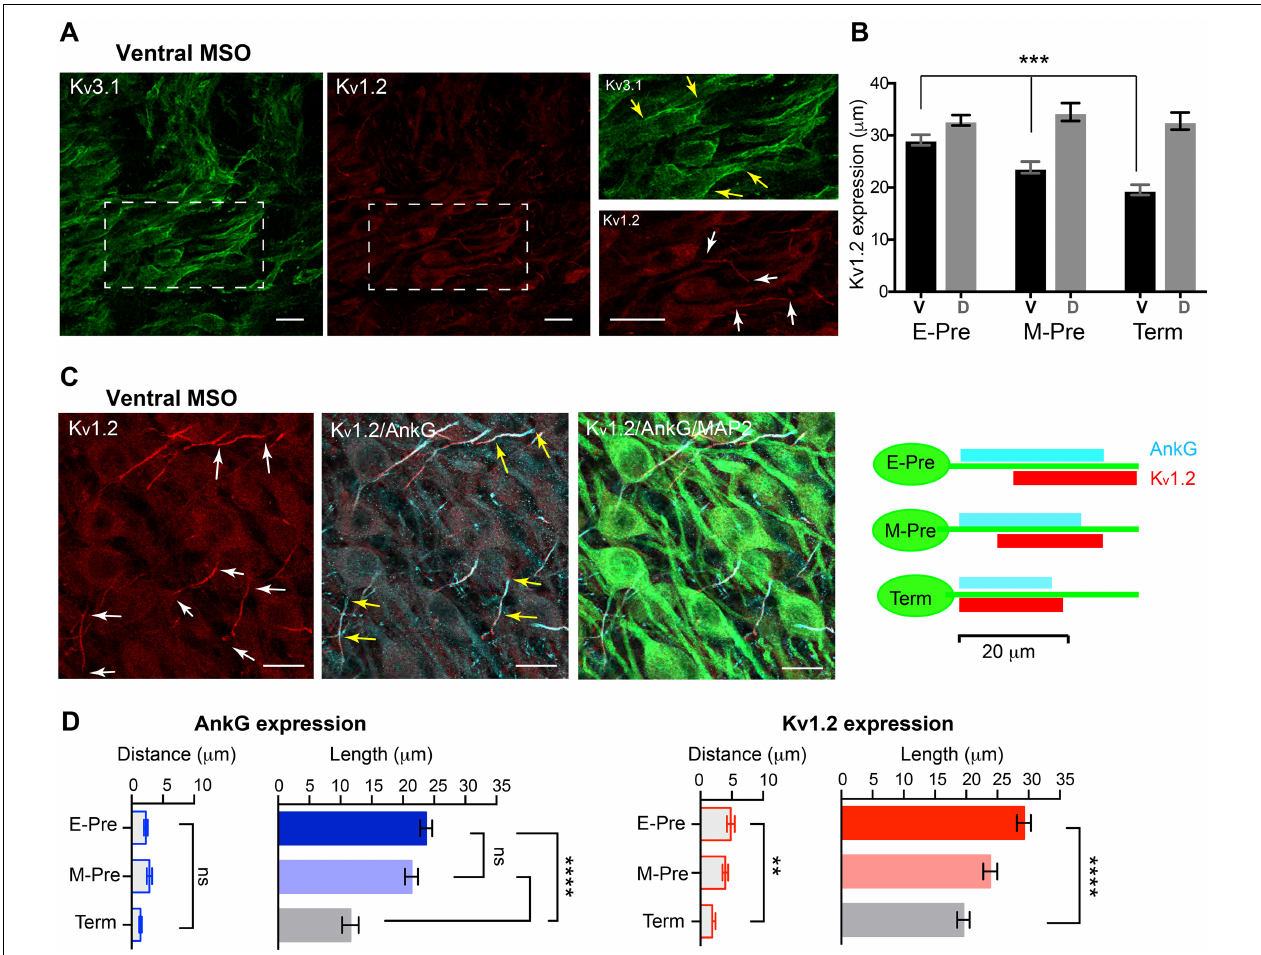
FIGURE 5 | Voltage-activated K + channel expression in the MSO of baboon neonates. (A) Expression of K v 3.1 (green) and K v 1.2 (red) channels in the ventral MSO from M-Pre neonate. (Right) Magnified image of MSO neurons immunolabelled by K v 3.1 and K v 1.2 in boxed area in A. Yellow arrows indicate K v 3.1 expression on somata and dendrites of MSO neurons and white arrows indicate K v 1.2 expression in the axon of MSO. Scale = 20 µ m. (B) Changes in the length of K v 1.2 expression on MSO axons in ventral and dorsal MSO in E-Pre, M-Pre, and Term neonates. Data were shown as mean ± s.e.m. *** < 0.001, one-way ANOVA test. (C) K v 1.2 expression (red) and colocalization with ankyrinG (AnkG, cyan) at the axon initial segment of an MSO neuron (MAP2, green) from an E-Pre baboon neonate. Scale = 20 µ m. (Right) Schematic of K v 1.2 expression pattern along the proximal axon of MSO neurons during fetal development. (D) The